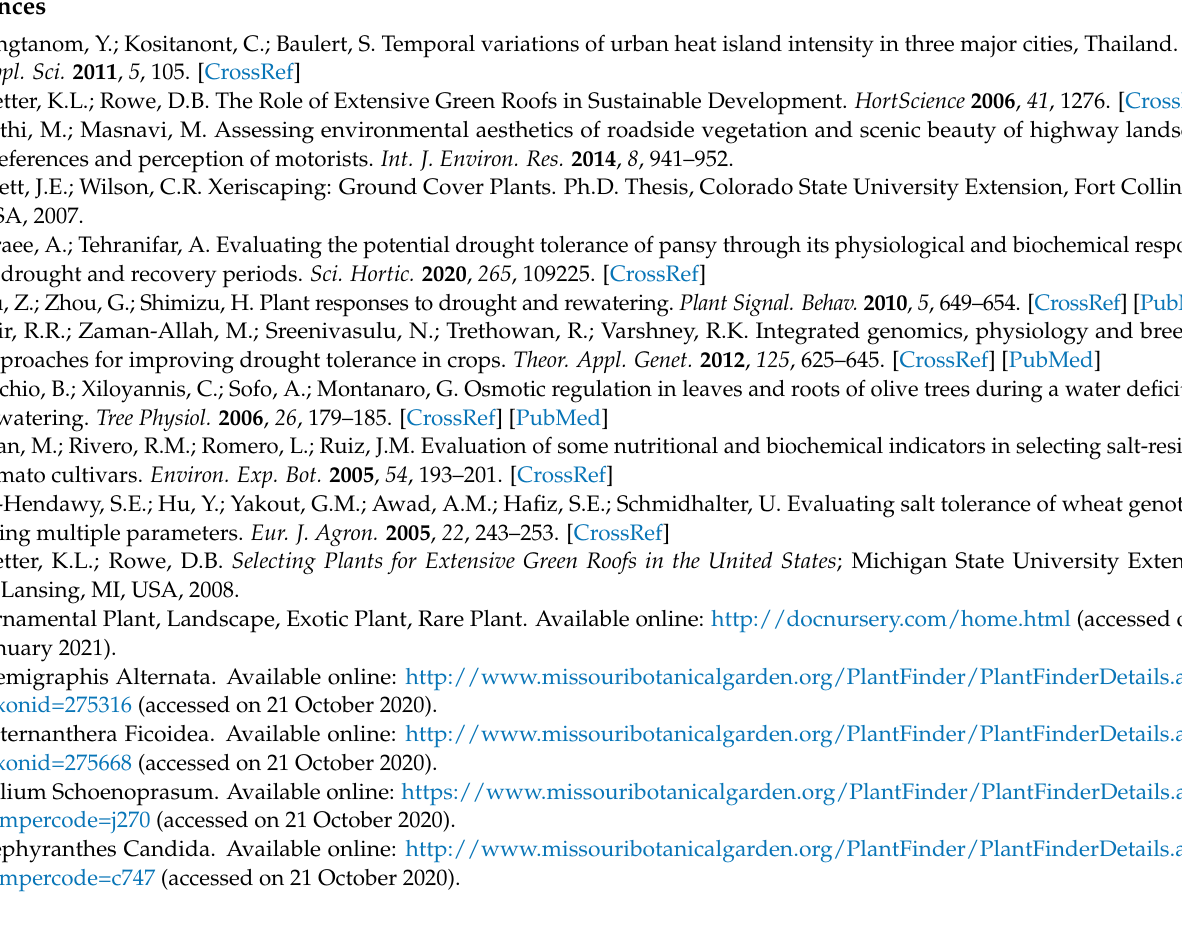
Figure A4. Images of plants under the drought treated condition at 5 time intervals: 0, 1, 3, 5 and 7 days after the sytart of the experiment (Coreopsis rosea: A , Trachelospermum jasmonides: B , Acalypha wilkesiana: C , Rynchosphora nervosa: D , Leucanthemum vulgare: E